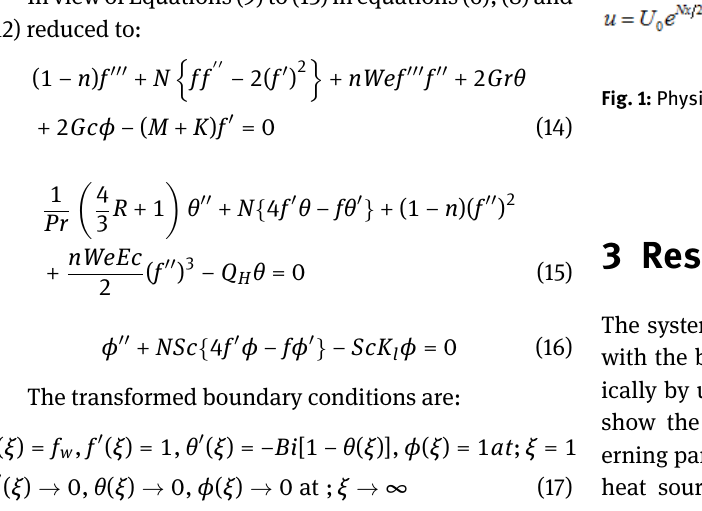
Fig. 1: Physical flow